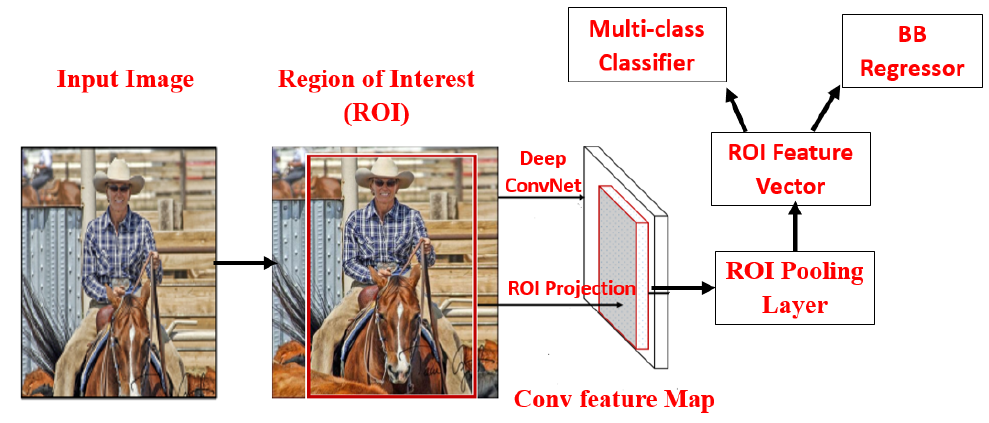
Figure 6. Fast RCNN architecture